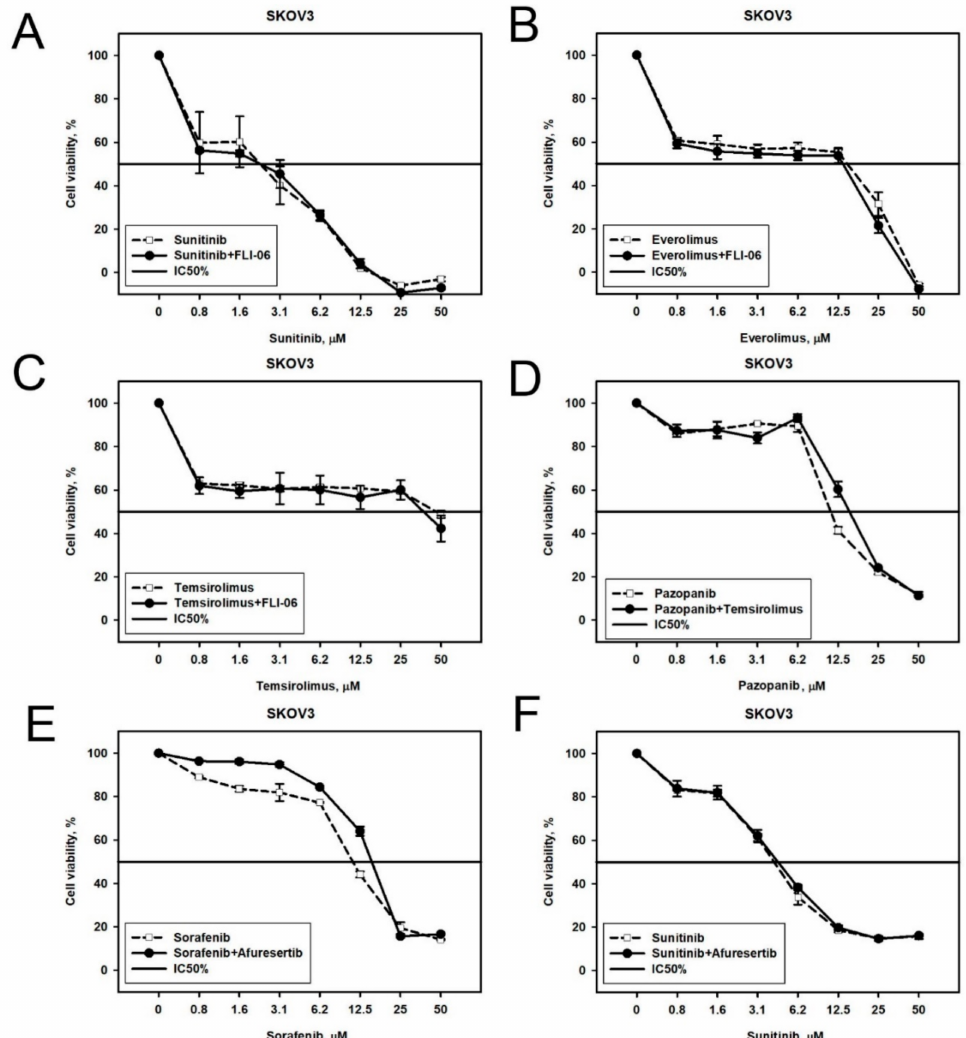
Figure 5. Viability of naïve SKOV-3 cells treated with different combinations of target drugs: ( A – C ) Sunitinib, Everolimus, or Temsirolimus, respectively, in combination with Notch inhibitor FLI-06 or alone; ( D ) Pazopanib in combination with mTOR inhibitor Temsirolimus; ( E , F ) Sorafenib or Sunitinib, respectively, in combination with Akt inhibitor Afuresertib or alone. Dashed line corresponds to single drug, solid